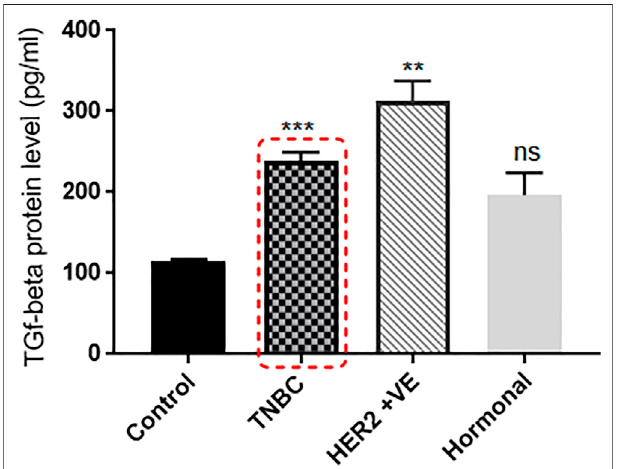
FIGURE 2 | TGF- β protein level is extremely elevated in the plasma of breast cancer patients. TGF- β plasma levels of patients with different BC subtypes ( n = 22) are compared to the TGF- β levels of healthy individuals. Plasma was separated from whole blood using the Ficoll separation protocol, and TGF- β concentrations were assessed using ELISA. p values; unpaired Student ’ s t-test.